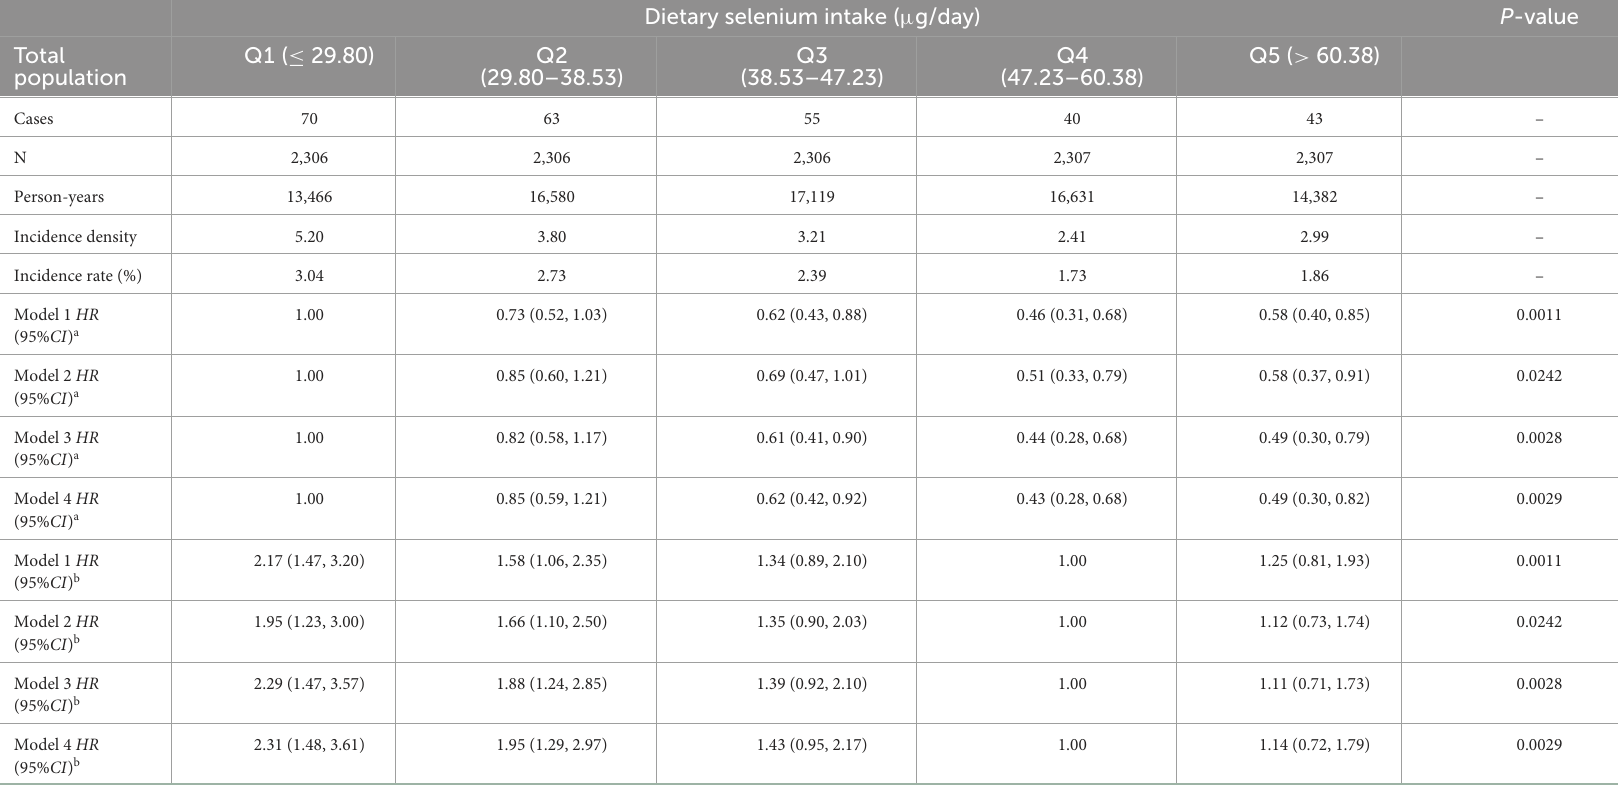
TABLE 4 Hazard ratios for stroke according to quintiles of dietary selenium intake. Dietary selenium intake ( µ g/day) P